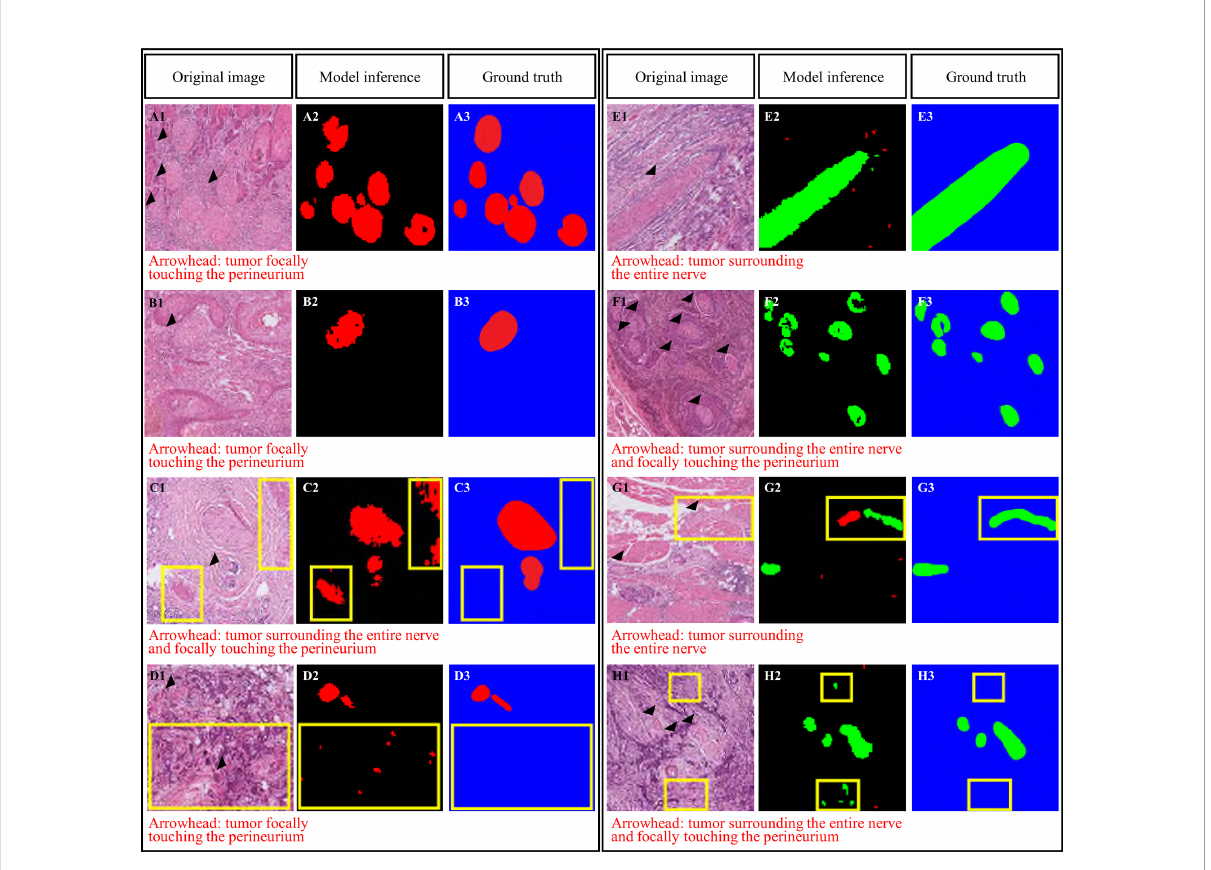
FIGURE 4 Domain knowledge enhanced yield (Domain-KEY)-based classi fi er for the presence of perineural invasion. Correct (A, B) and incorrect (C, D) identi fi cation of nerve fi bers. Incorrect classi fi cation resulted from the presence of similar patterns (C) or noisy signals (D) . Correct (E, F) and incorrect (G, H) identi fi cation of perineural invasion. Incorrect classi fi cation resulted from the presence of fi broblasts surrounding the nerve and inappropriate separation of nerve fi bers (G) or noisy signals (H) . The purple color denotes the recognition of nerve structures, whereas normal nerves are marked in red. Areas of perineural invasion are highlighted in green with a black/blue background. The yellow rectangle denotes an area of incorrect classi fi cation.